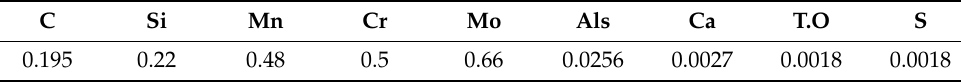
Table 1. Main compositions of C110 billet